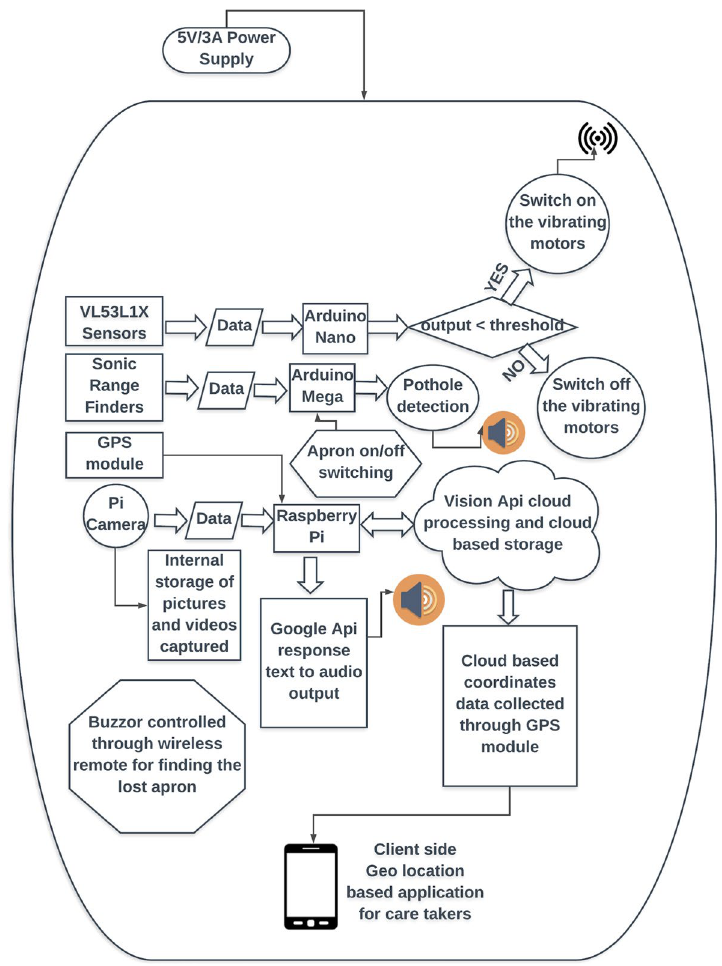
Fig. 2 The integrated working flow diagram of the Blind’s